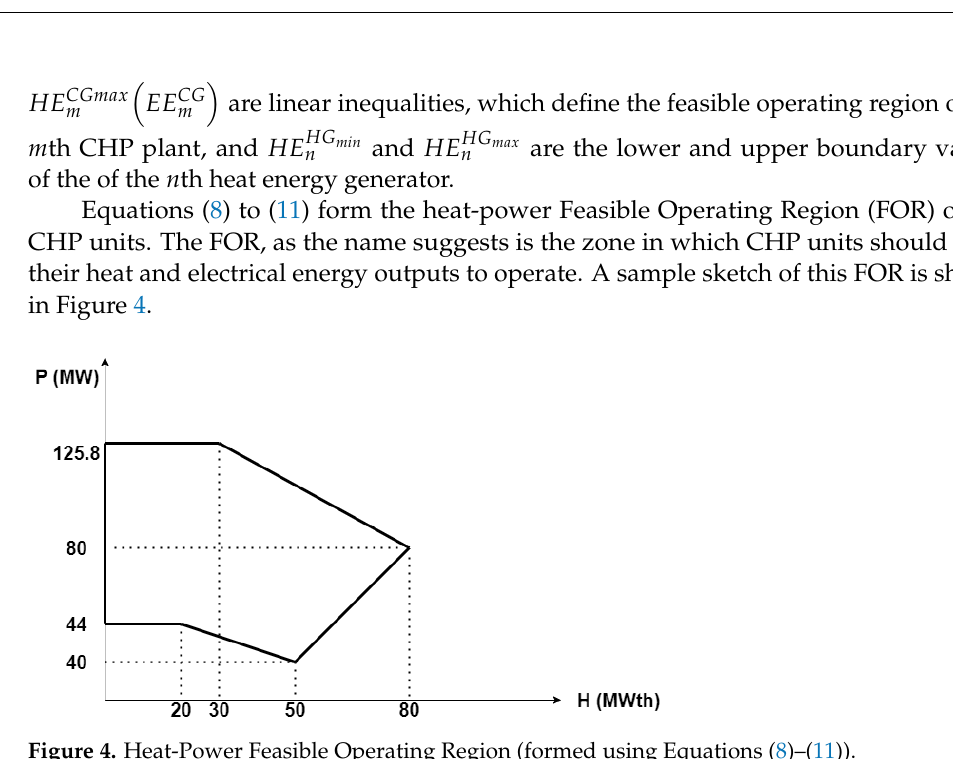
Figure 4. Heat-Power Feasible Operating Region (formed using Equations